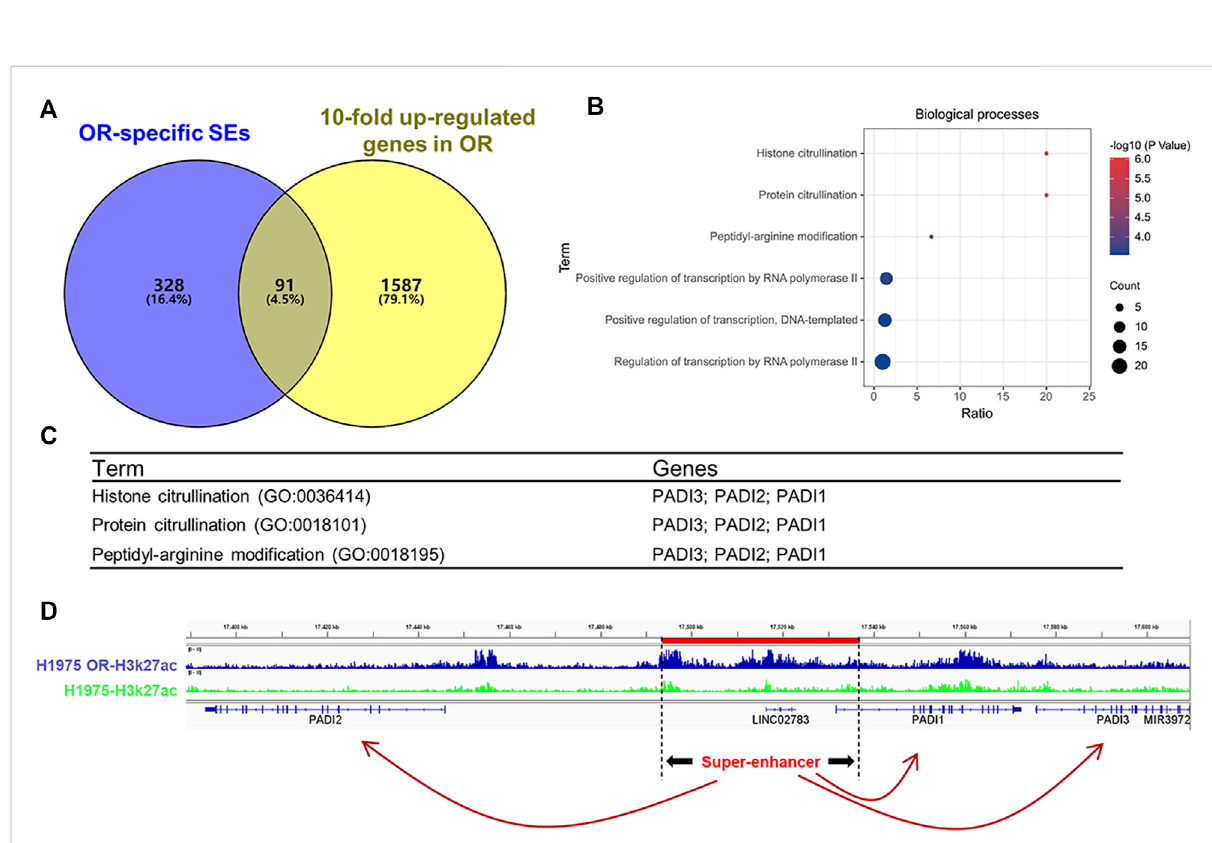
FIGURE 4 PADI family genes were OR-speci fi c SEs-associated genes. (A) Venn diagram shows the intersection of OR-speci fi c SEs-associated genes and genes that are more than 10-fold up-regulated in H1975 OR cells. (B) Gene ontology (GO) analysis of enriched biological processes for the 91 OR- speci fi cSEs-associatedgenes. (C) Thegenesinvolvedinthetop3enrichedbiologicalprocesses. (D) H3K27acChIP-Seqbindingpro fi lesshowtheSE and associated PADI genes in H1975 cells and H1975 OR